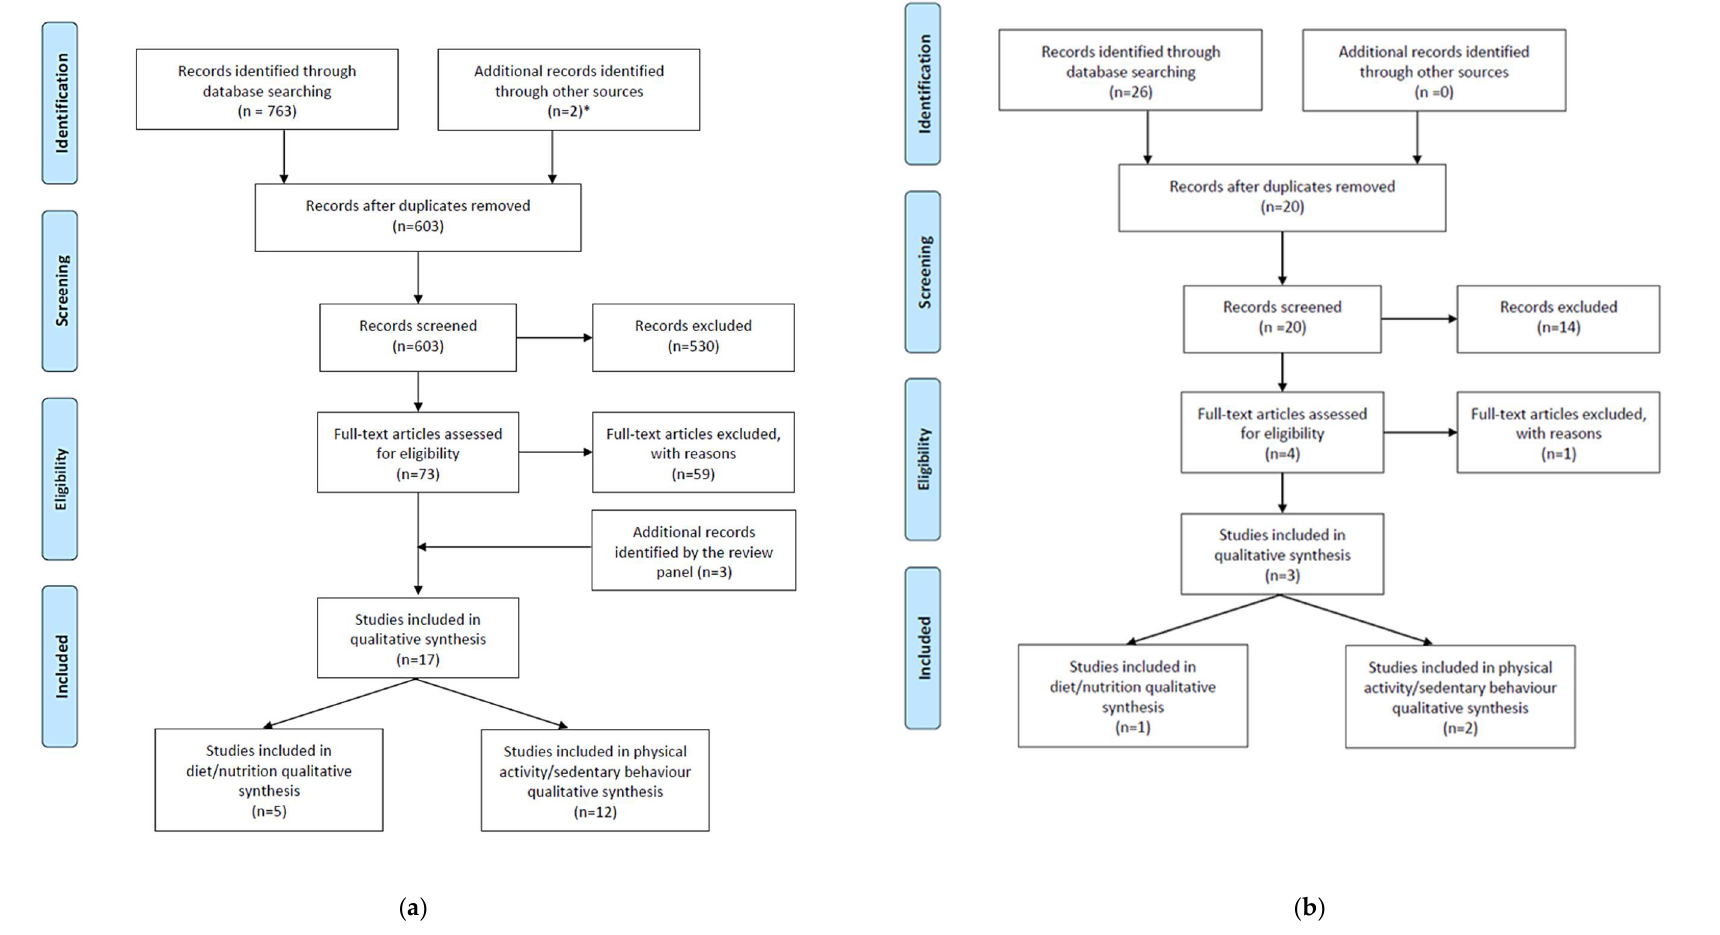
Figure 2. Flow of information through the different phases of the rapid review for identification of ( a ) studies on diet and physical activity/sedentary behaviour, and ( b ) studies on diet and physical activity/sedentary behaviour that specifically relate to Aboriginal and Torres Strait Islander children. The PRISMA (Preferred Reporting Items for Systematic Reviews and Meta-Analyses) diagrams are modified from Moher et al. [64]. *